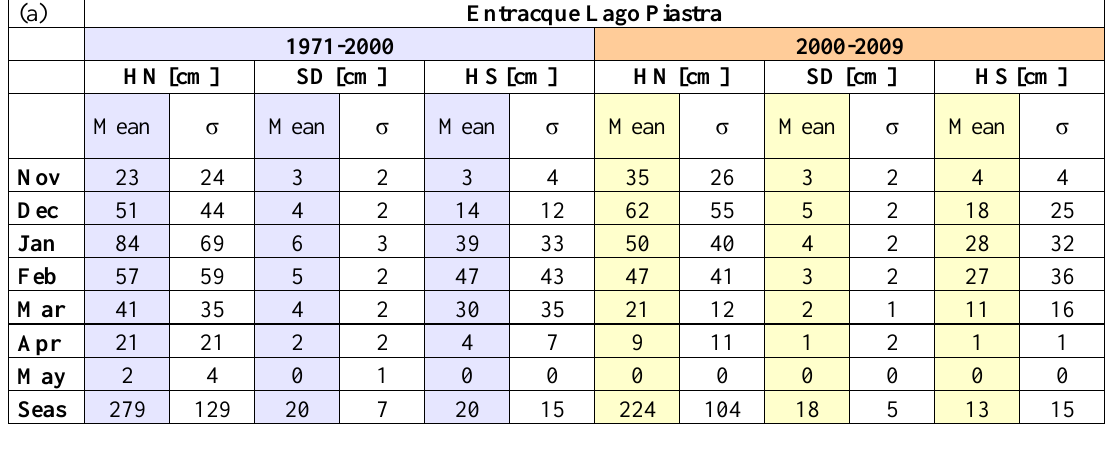
Table 2. Mean monthly cumulated snow precipitation (HN), average number of snowy days per month (SD) and mean monthly snow depth (HS) over the periods 1971–2000 and 2000–2009 at the Entracque Lago Piastra (a), Vinadio Riofreddo (b), and Pontechianale Lago Castello (c) stations, with their standard deviations (σ). The 30 year seasonal averages include November and December 1970